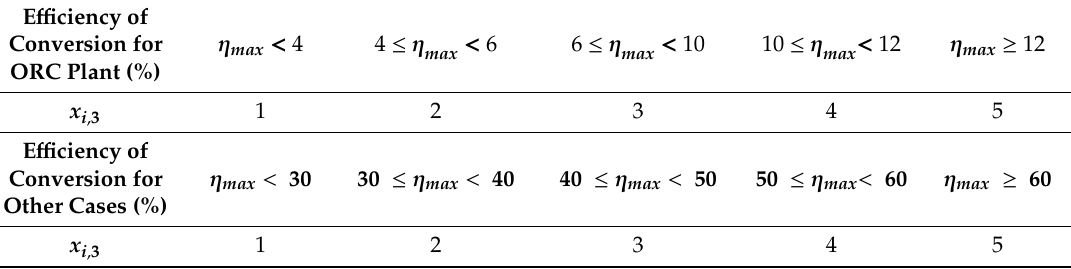
Table 3. Performance values x i ,3 for 3rd criterion.